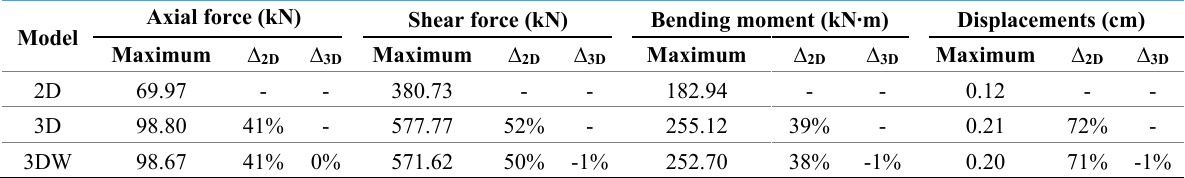
Table 6. Maximum forces and displacements in the support beam of Wall